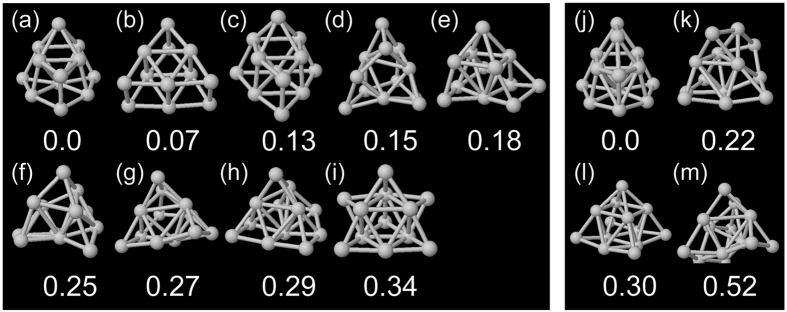
Relatively stable geometries of ((a–i)) Pt12 and ((j–m)) Pt13. The values are the energies relative to that of the most stable one (in eV).